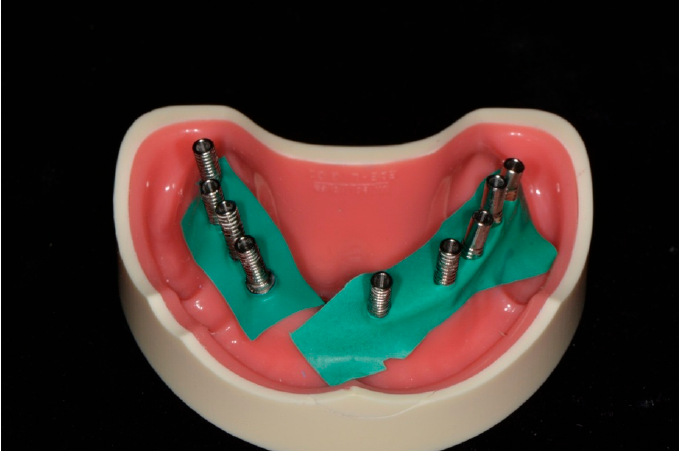
Figure 8. Rubber dam placed beneath the cylinders.